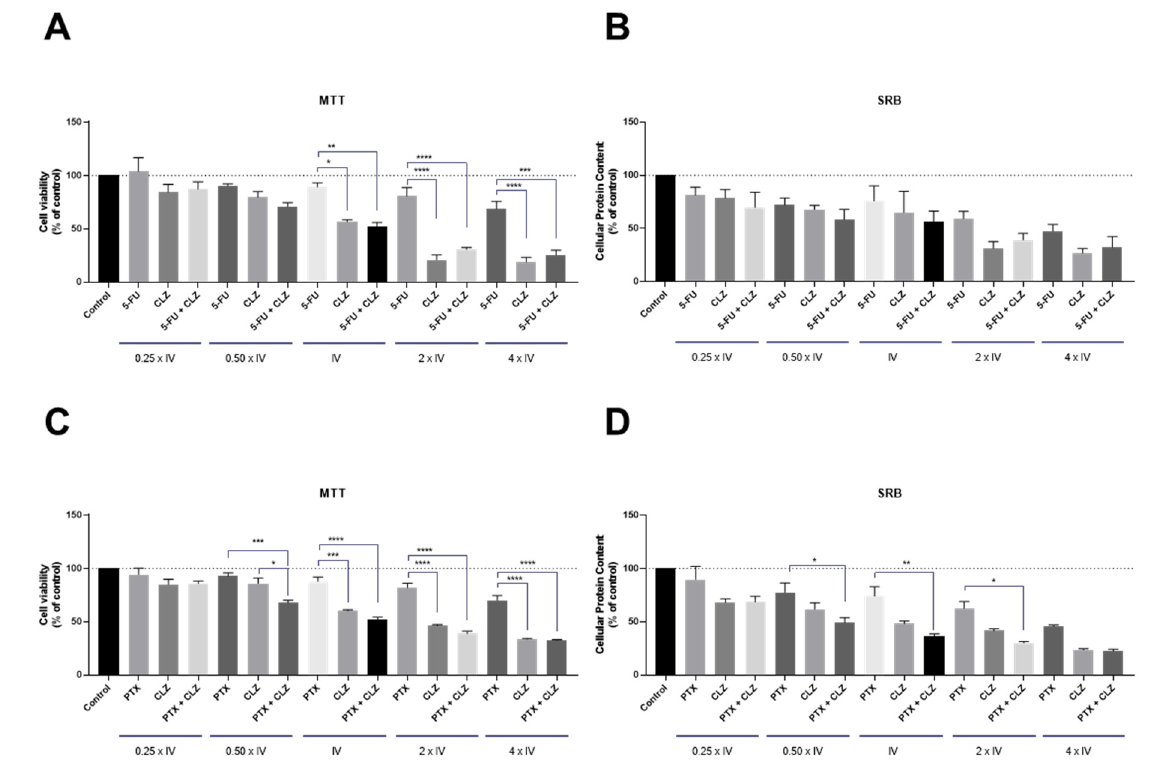
Figure 9. Cytotoxic effects of the combination of CLZ with ( A , B ) 5-FU and ( C , D ) PTX on the viability (right panel) and cell protein (left panel) content of HT-29 and PC-3 cells, respectively. Cell viability and protein content were assessed by MTT and SRB assays, respectively, after 48 h of exposure to each treatment. The results are expressed in the percentage of cell viability relative to untreated control cells. *, **, *** and **** indicate p < 0.05, p < 0.01, p < 0.001 and p < 0.0001, respectively, when compared to the control. All data are presented as the mean ± SEM of three independent experiments.